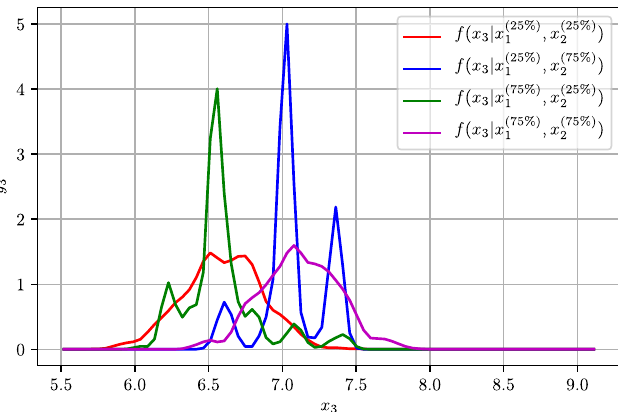
Fig. 8. Visualization of the Rosenblatt conditional density f ( x 3 | x 1 , x 2